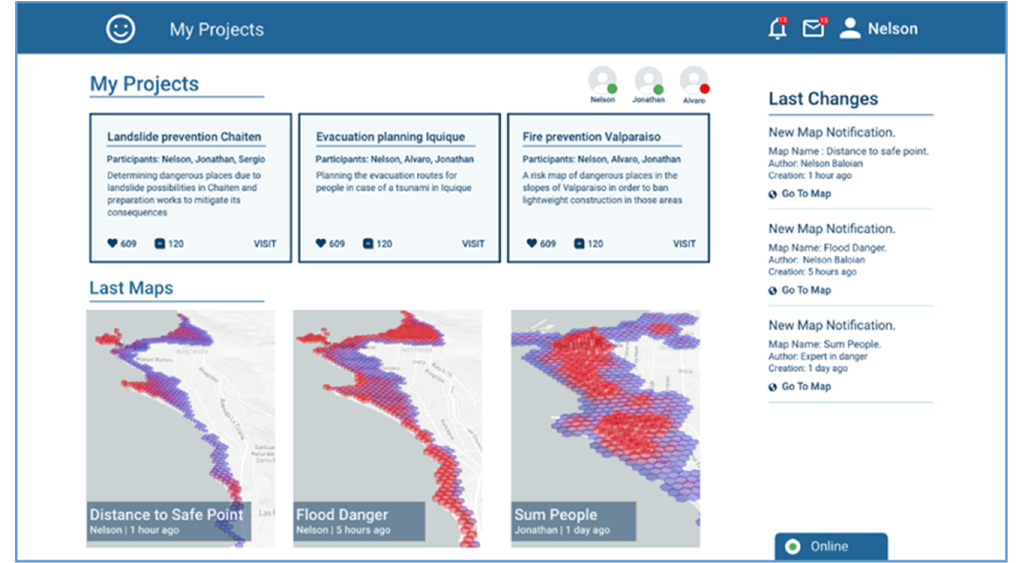
Figure 4. Screenshots of the application showing the available projects for user Nelson.